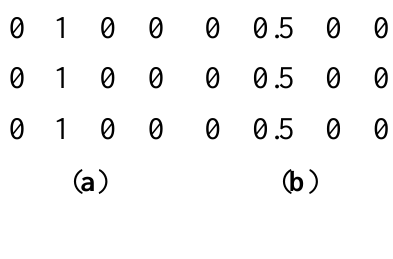
Figure 2. ( a ) Finite differencing of sharp edge and ( b ) Finite differencing of less prominent